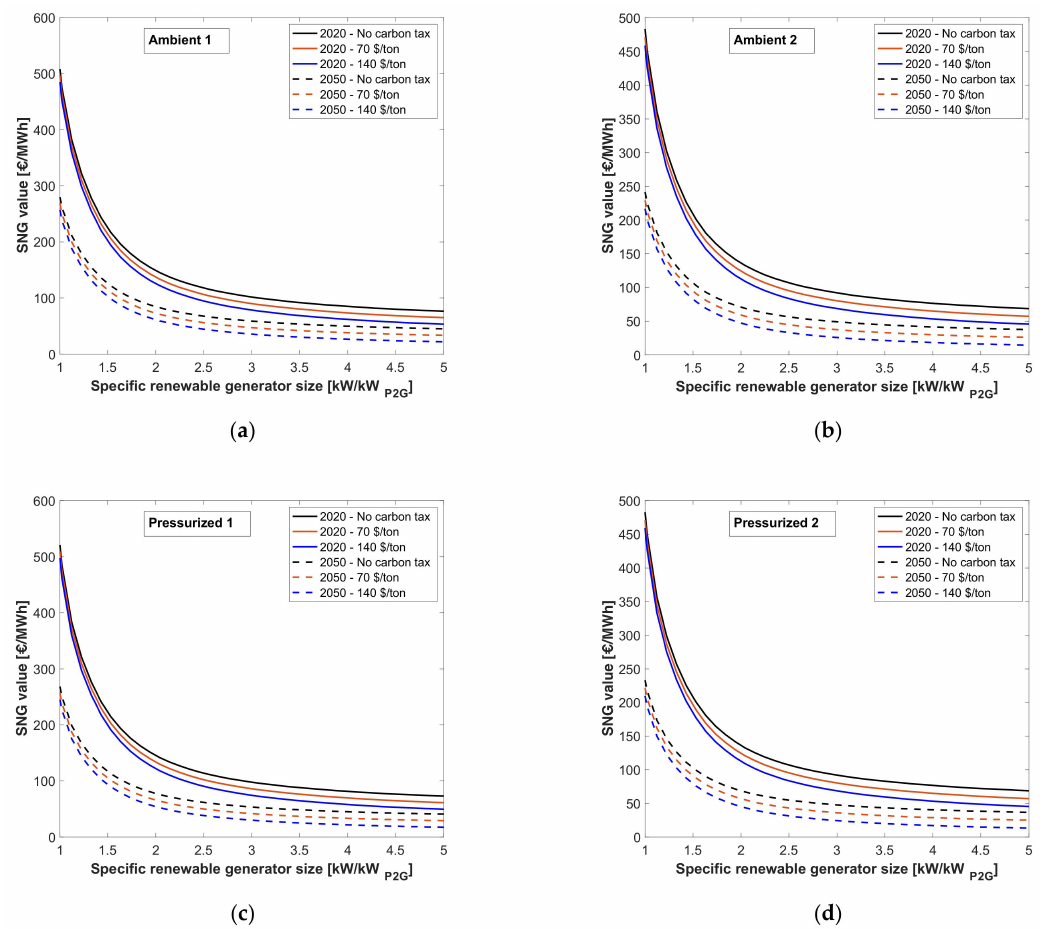
Figure 15. SNG value as a function of the SOEC cost development (year 2020 and year 2050 SOEC costs for a medium power size are considered), the renewable generator size and the carbon tax for the several configurations: ( a ) Ambient 1; ( b ) Ambient 2; ( c ) Pressurized 1; and ( d ) Pressurized